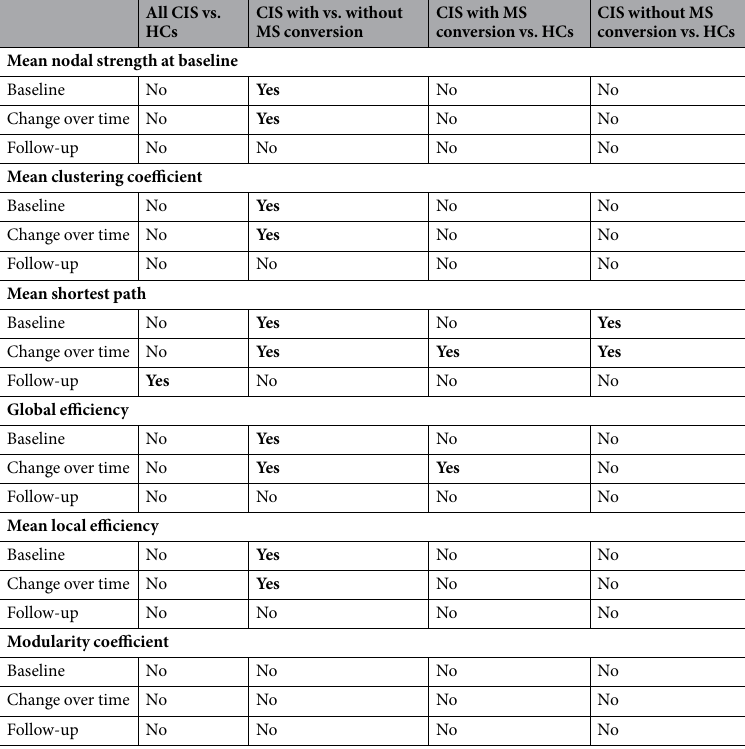
Table 4. Summary table of the differences between groups. This table indicates whether there were significant differences between groups (indicated as ‘Yes’) or not (indicated as ‘No’). Abbreviations: CIS: clinically isolated syndrome; HCs: healthy controls; MS: multiple